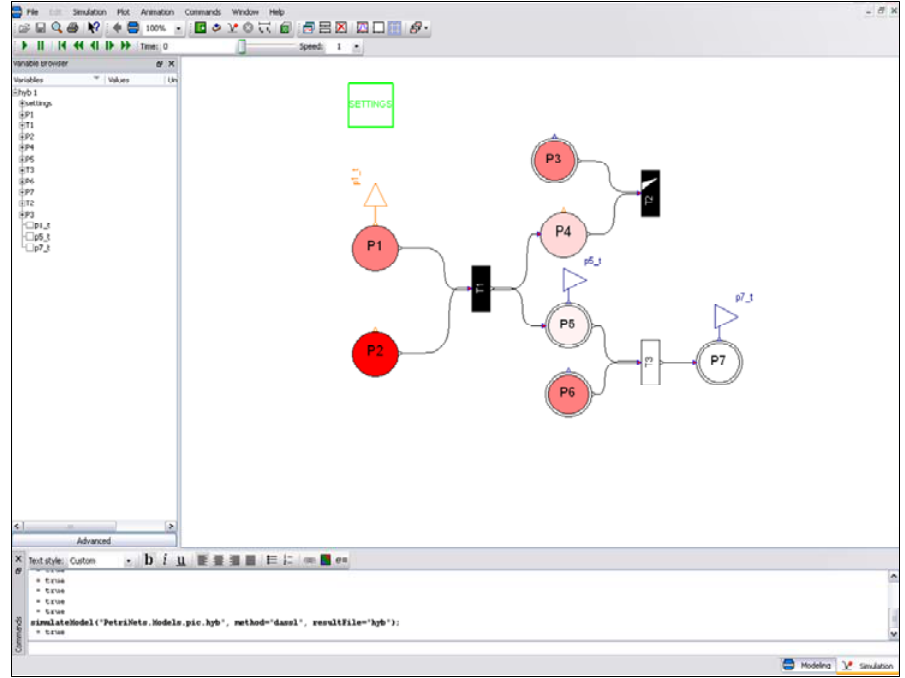
Figure 17: Simulati on view of a Petri Net model in Dymola.